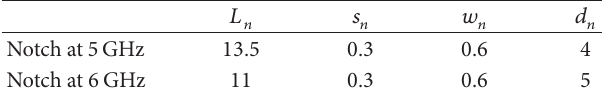
Table 3: Dimensions of the resonators realizing the frequency notch. All dimensions are in